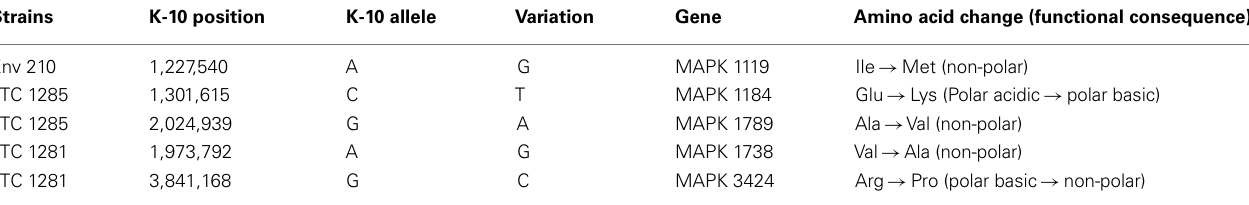
Table 5 |A list of nSNP in cytochrome P450